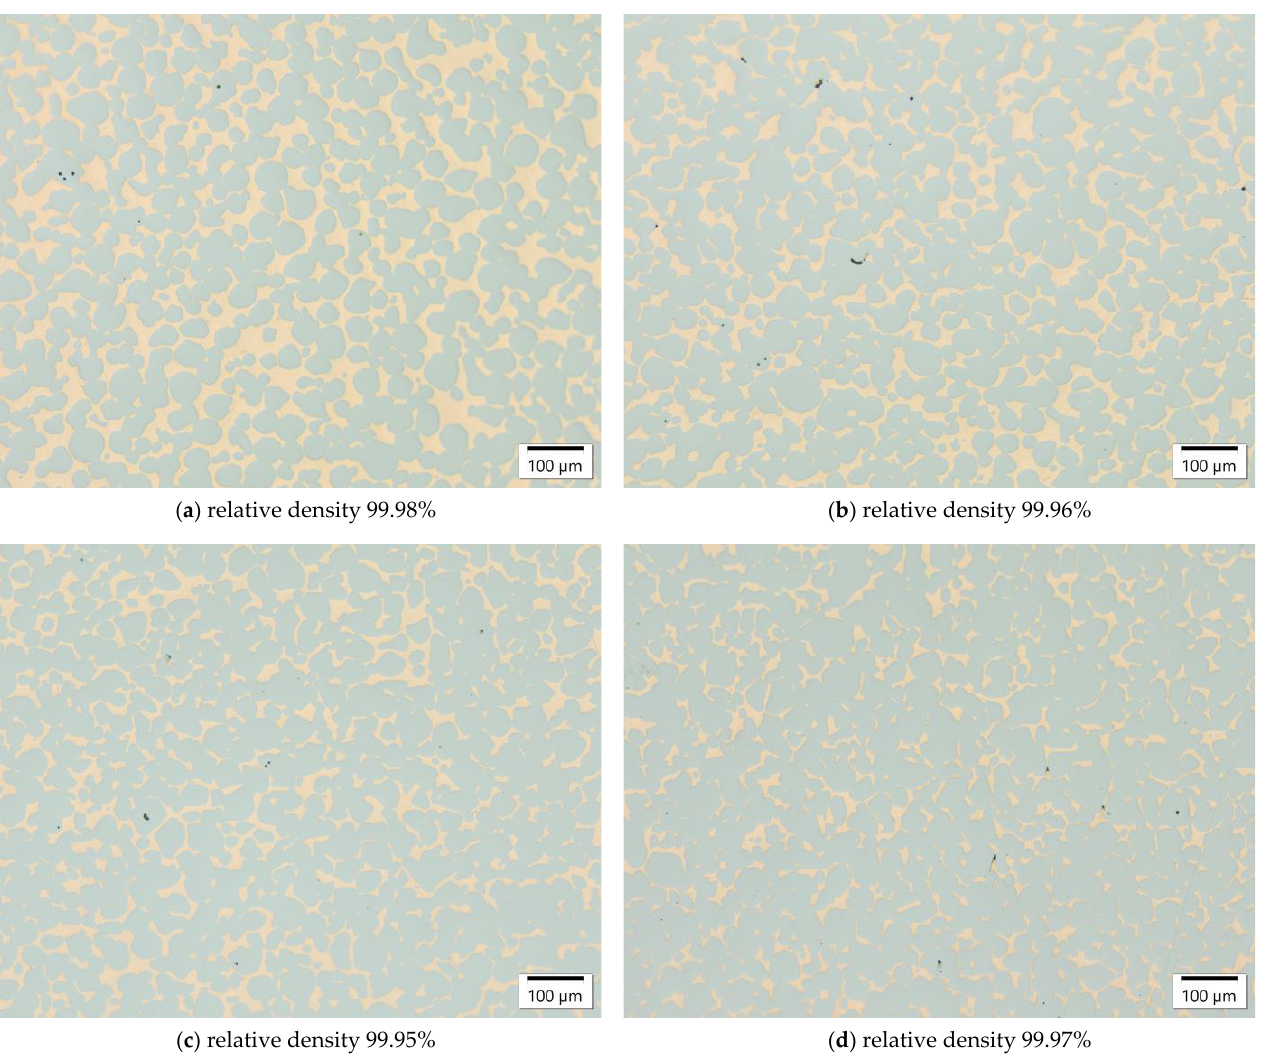
Figure 5 . H11/Cu composite materials manufactured from H11 tool steel preforms with ( a ) 0 wt.%, ( b ) 5 wt.%, ( c ) 10 wt.% and ( d ) 15 wt.% fine powder contents due to infiltration with Cu at 1125 °C (3 h), imaged by optical microscopy.